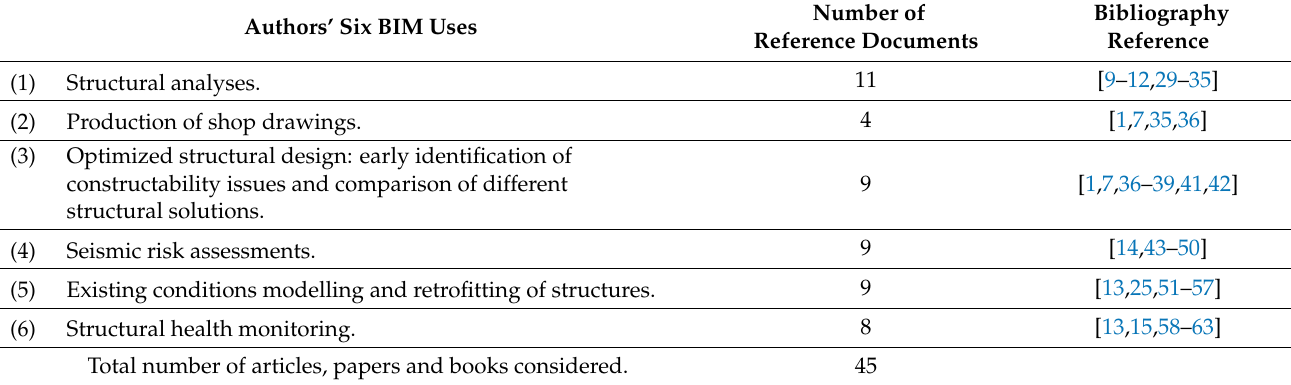
Table 3. Organization of the reference bibliography according to the six identified BIM uses.